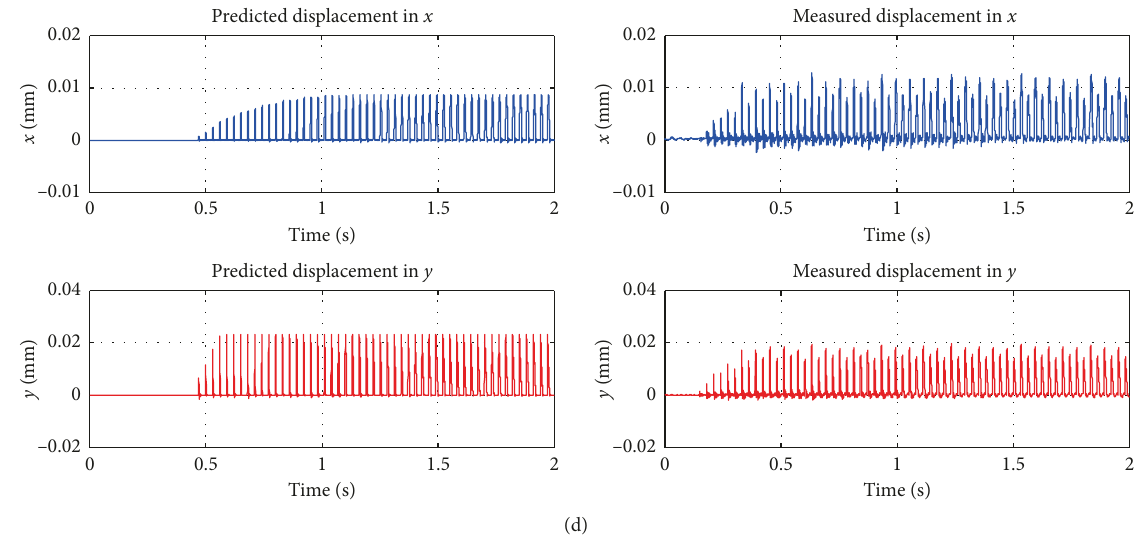
Figure 15: Simulated and measured cutter vibrations when the cutter entering the workpiece along a straight line: (a) Test No. 3, (b) Test No. 6, (c) Test No. 7, and (d) Test No. 8.